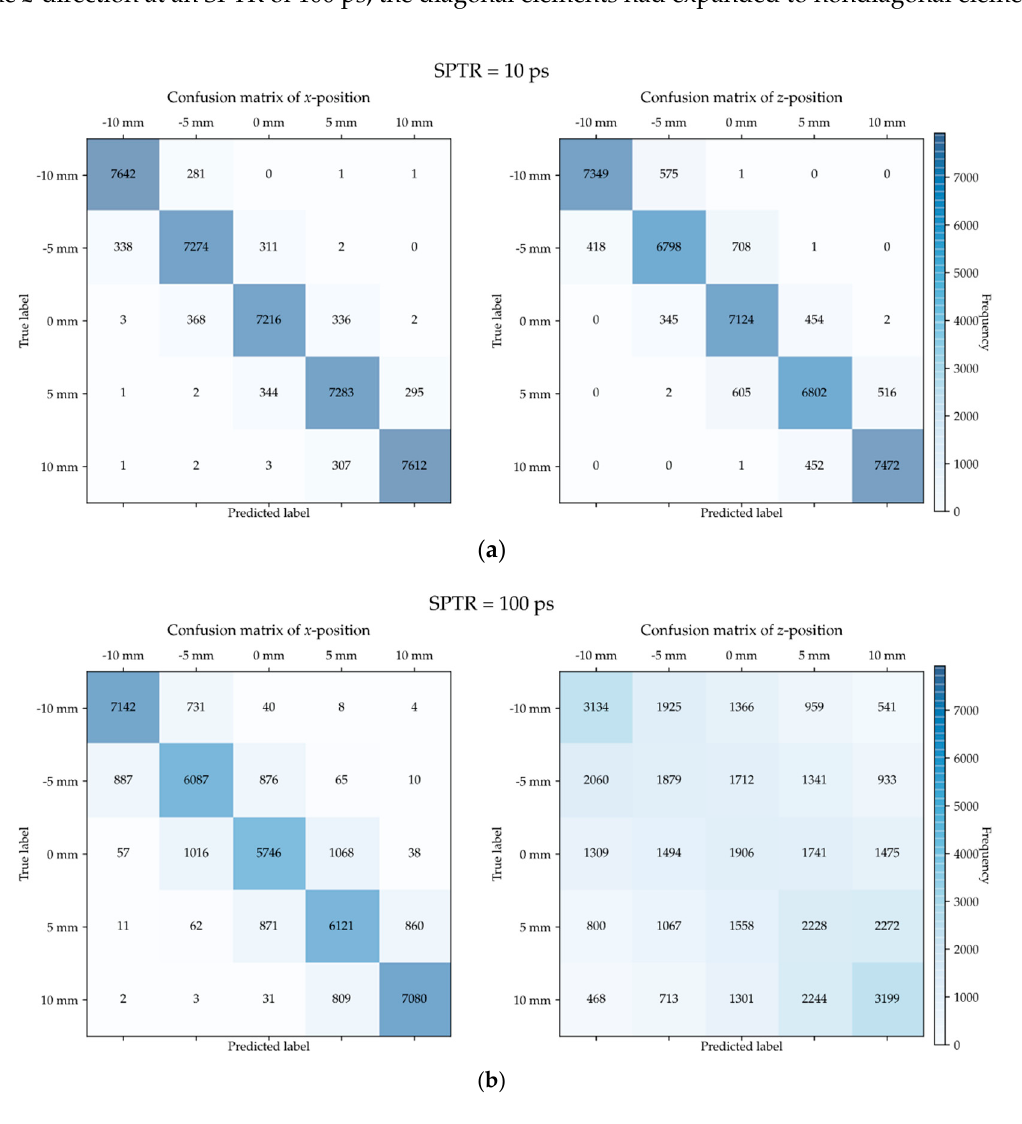
Figure 5. Confusion matrix in the x - and z -directions at an SPTR of ( a ) 10 ps, and ( b ) 100 ps, respectively. Results in the y -direction were omitted because these were almost same as those in the x -direction. Readout pitch was fixed at 3 mm. As the number of events in the test dataset was 39,625, the maximum number of events in diagonal elements is considered to be 7925.